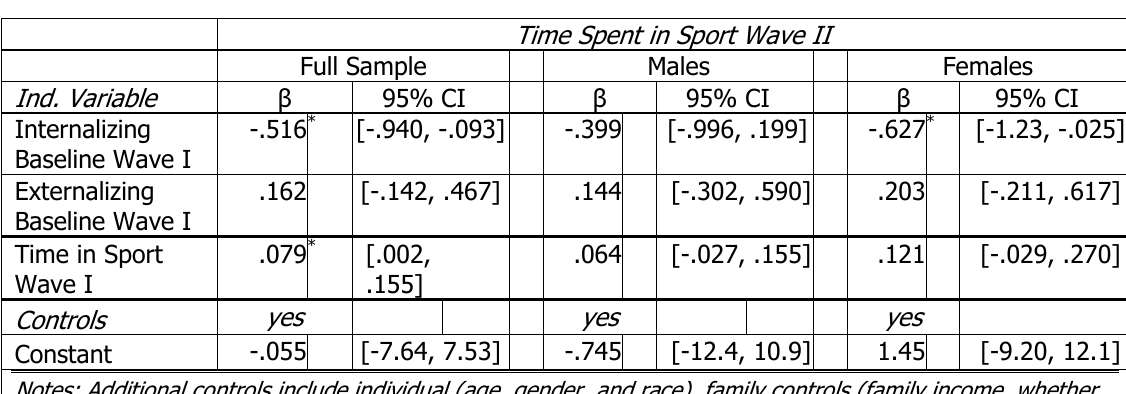
Regression Coefficients for Predicting Time in